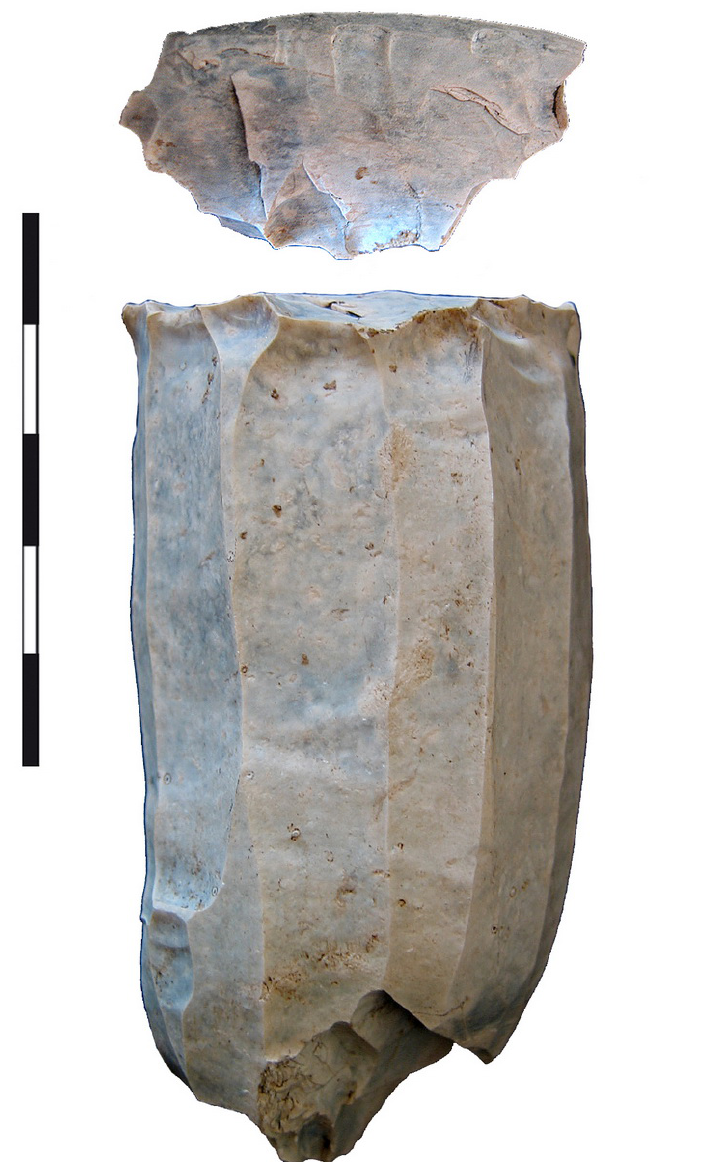
Figure 13. Nucléus du Néolithique ancien (Rubané récent du Bassin de la Seine) de Berry-au-Bac « Le vieux Tordoir » (Allard 2014). (L’échelle est de 5 cm divisée en segments de 1 cm.) Figure 13. Blade core of the Early Neolithic (Linearbandceramic of the Seine Basin) Berry-au-Bac "The Vieux Tordoir" (Allard 2014). (Scale bar is 5 cm wide, divided into 1 cm